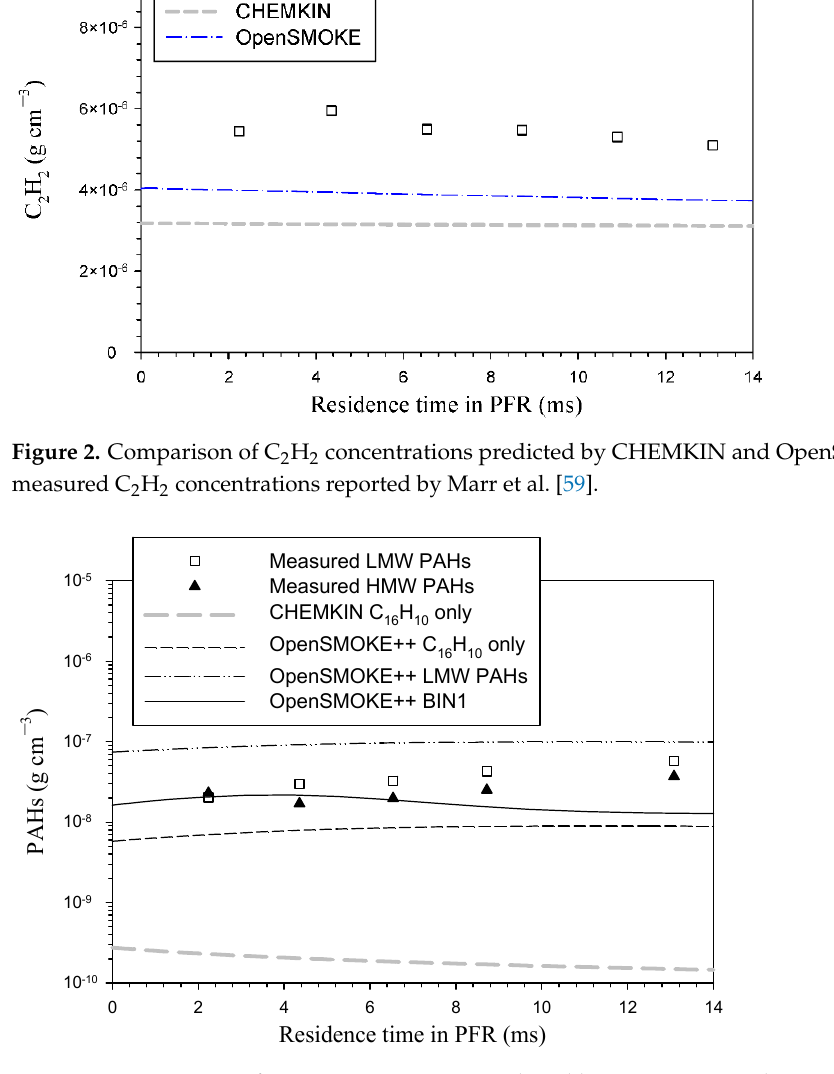
Figure 3. Comparison of PAH concentrations predicted by CHEMKIN and OpenSMOKE++ with measured data.